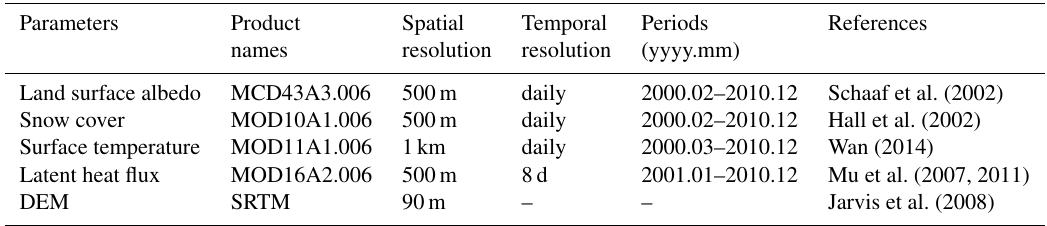
Table 1. Specifications of the remote sensing data used in the study. Parameters Product Spatial Temporal Land surface albedo Snow